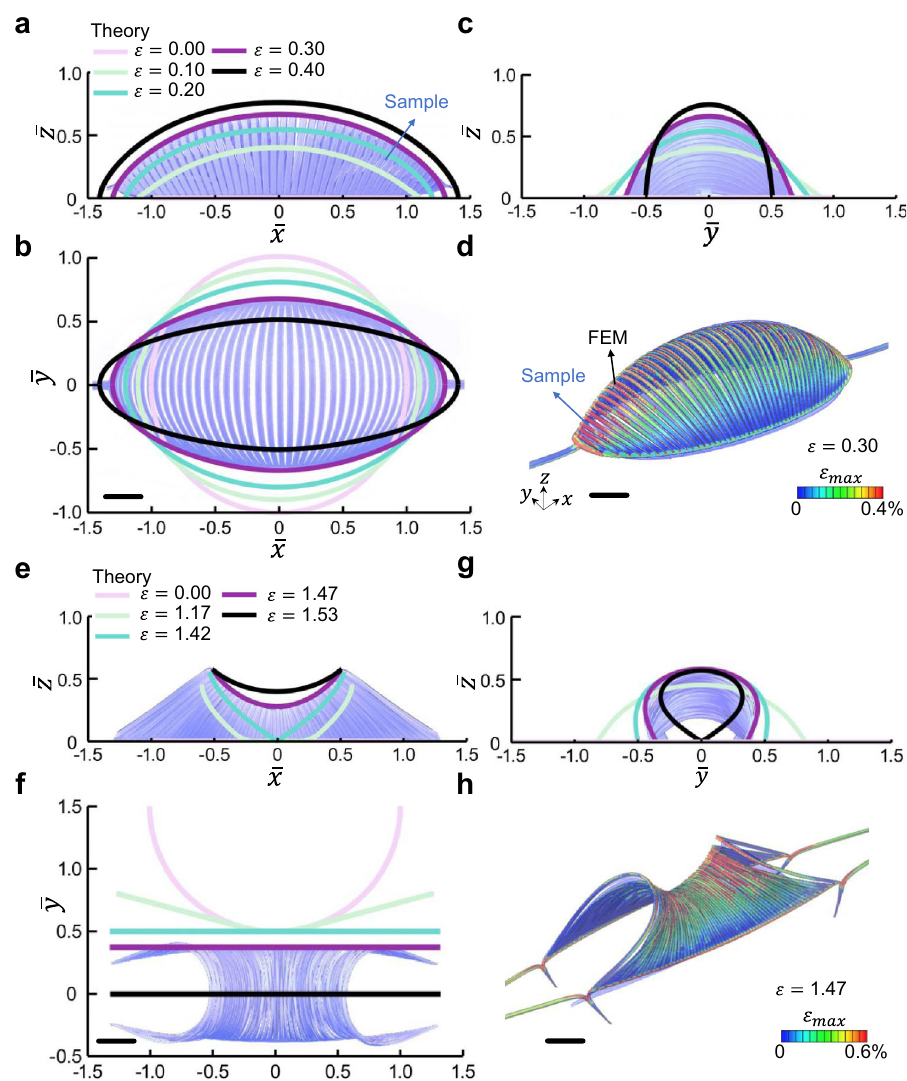
Fig. 2 Quantifying the 3D shape shifting through analytical modeling and simulation. a – h Predicted shape changes with the applied strain ε in the samples of spheroidal ( a – d ) and saddle shapes ( e – h ). a , e Front-view pro fi le. b , f Top-view pro fi le. c , g Side-view pro fi le. d , h Overlapping of FEM simulation results (contours of the maximum principal strain ε max ) with the experimental image at ε = 0.30 ( d ) and 1.47 ( h ). Scale bars = 10